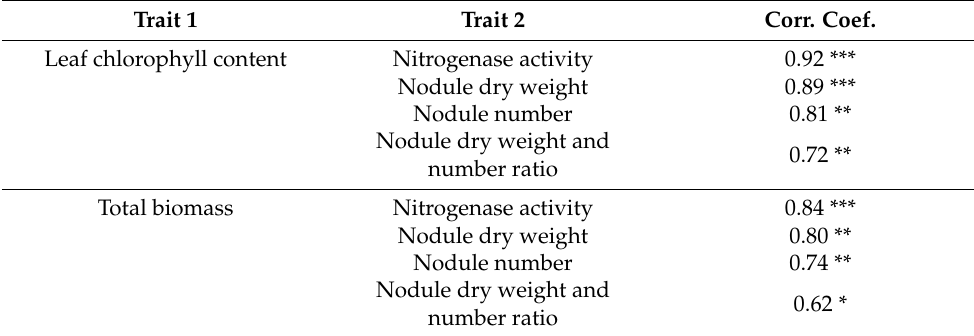
Table 3. Relationships between traits related to